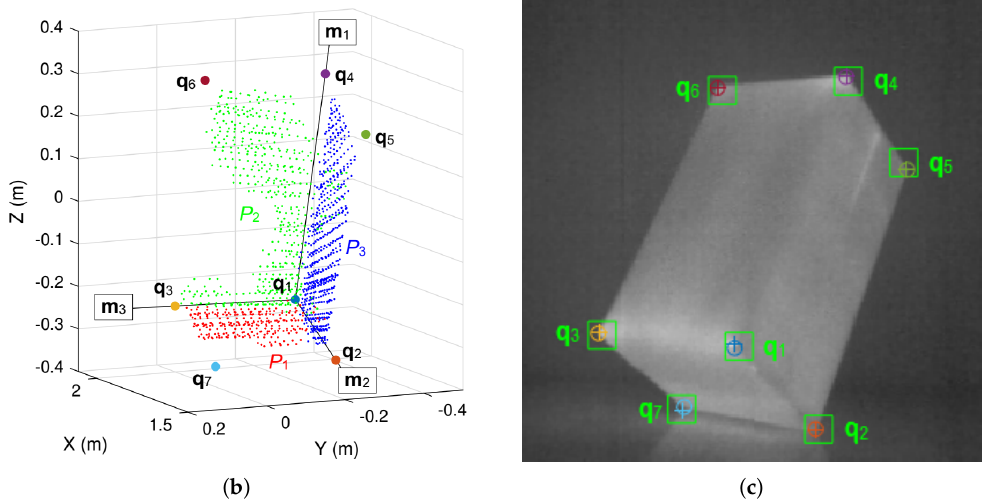
Figure 2. ( a ) Overview of the calibration process. ( b ) Refined target model produced by the calibration algorithm, showing the orientation of the edge vectors and the position of the corners. The line of sight of the instruments is parallel to the positive X -axis. Here, the box is seen from its right side. The front, side, and top walls (sorted by increasing elevation of the centroid) are colored red, blue, and green, respectively. If the box had been viewed from the left side, the reference frame would have been rotated (with the side wall in green and the top wall in blue) without changing the ordering of the corners. ( c ) Grayscale thermal image of the target, highlighting the regions in which the Harris-Stephens algorithm searches for each corner. Colored crosses mark the position of the image points and colored circles mark the position of the reprojected world points. Each point is represented with the same color as the corresponding corner in the 3D box